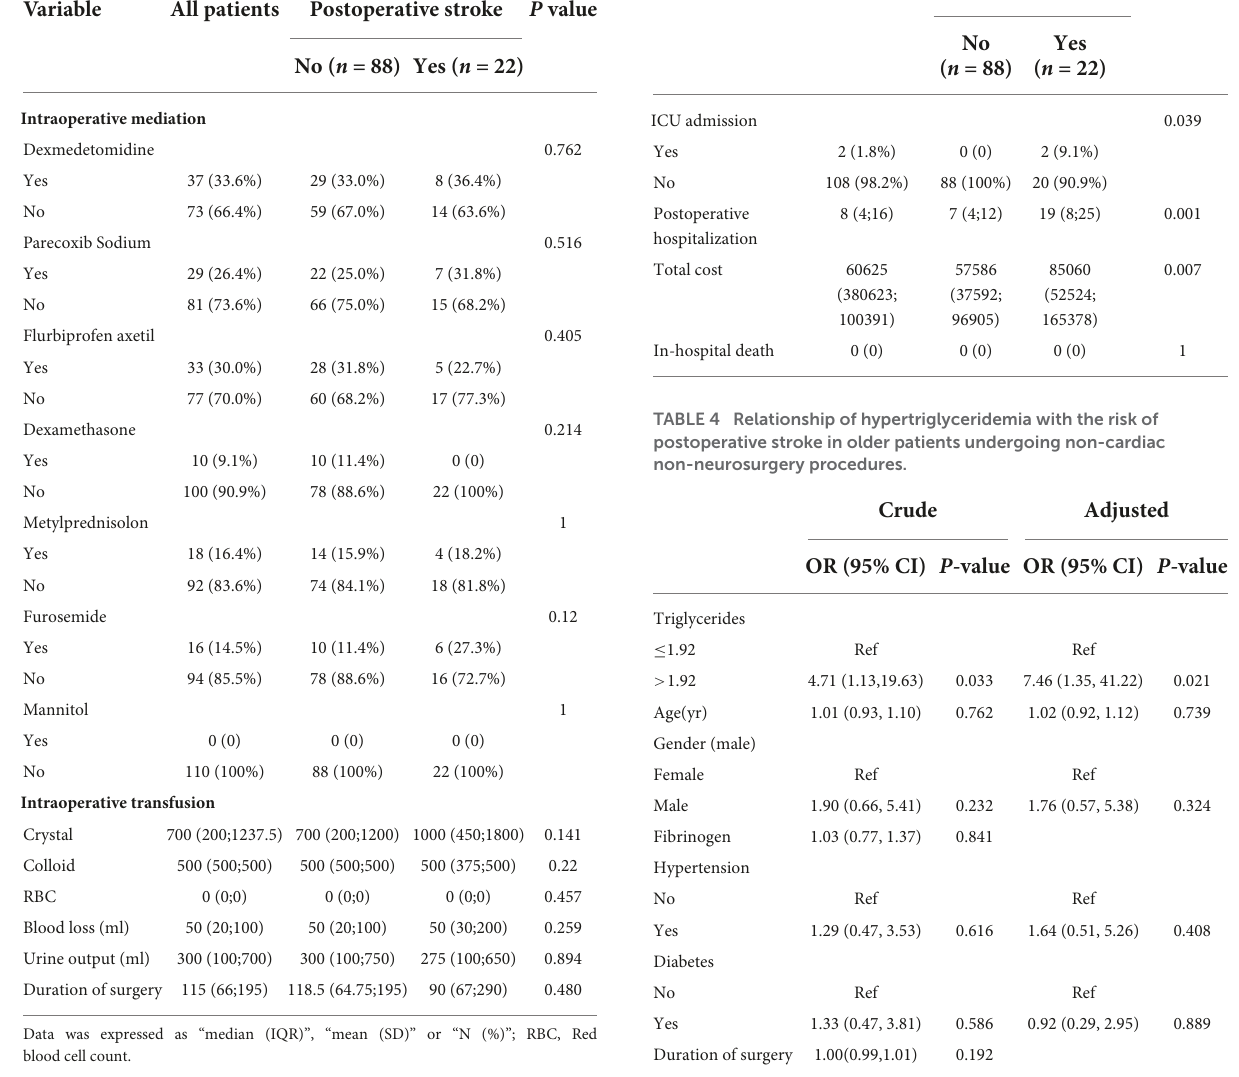
TABLE 2 Intraoperative characteristics of patients between two groups.